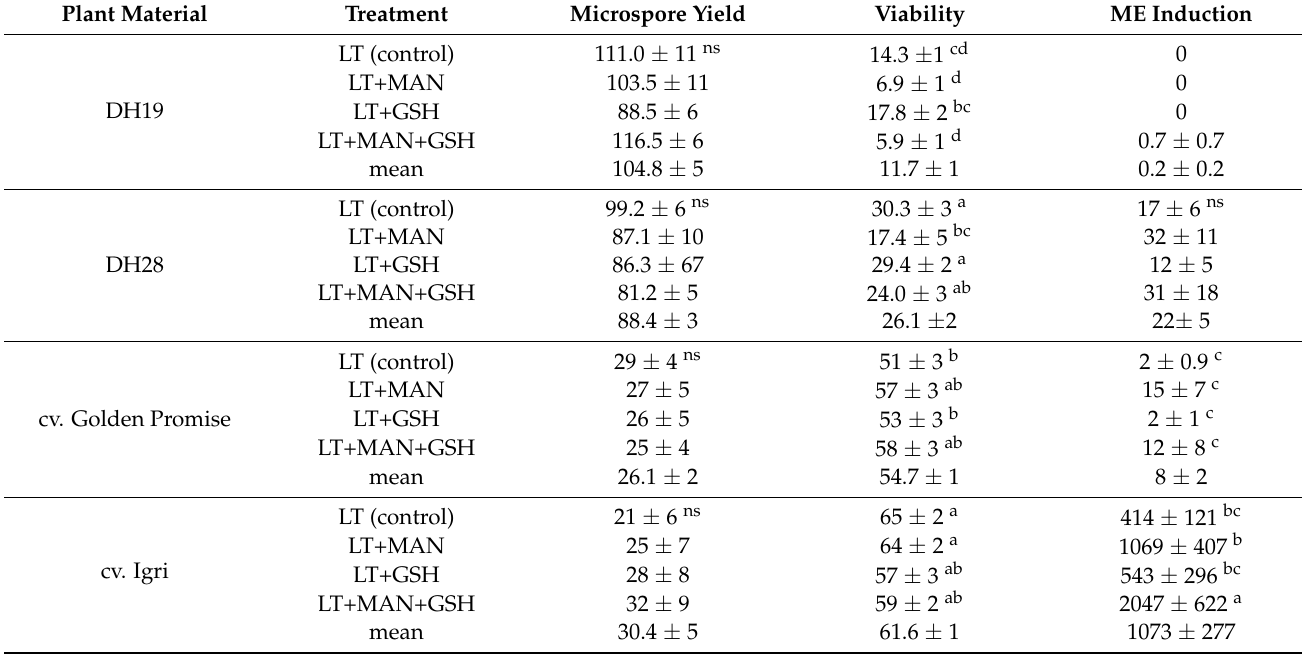
Table 1. The effect of tillers pre-treatment on microspore yield ( × 10 3 ), viability (%) and the effectiveness of microspore embryogenesis (ME) induction (ELS/spike) in isolated microspore cultures of two DH lines of triticale and two cultivars of barley. Data represent means from 3–5 biological replications (isolations) ± SE. Statistical analysis was performed separately for triticale and barley. Data marked with different letters differ significantly according to the Duncan test ( p ≤ 0.05); ns, not significant. Plant